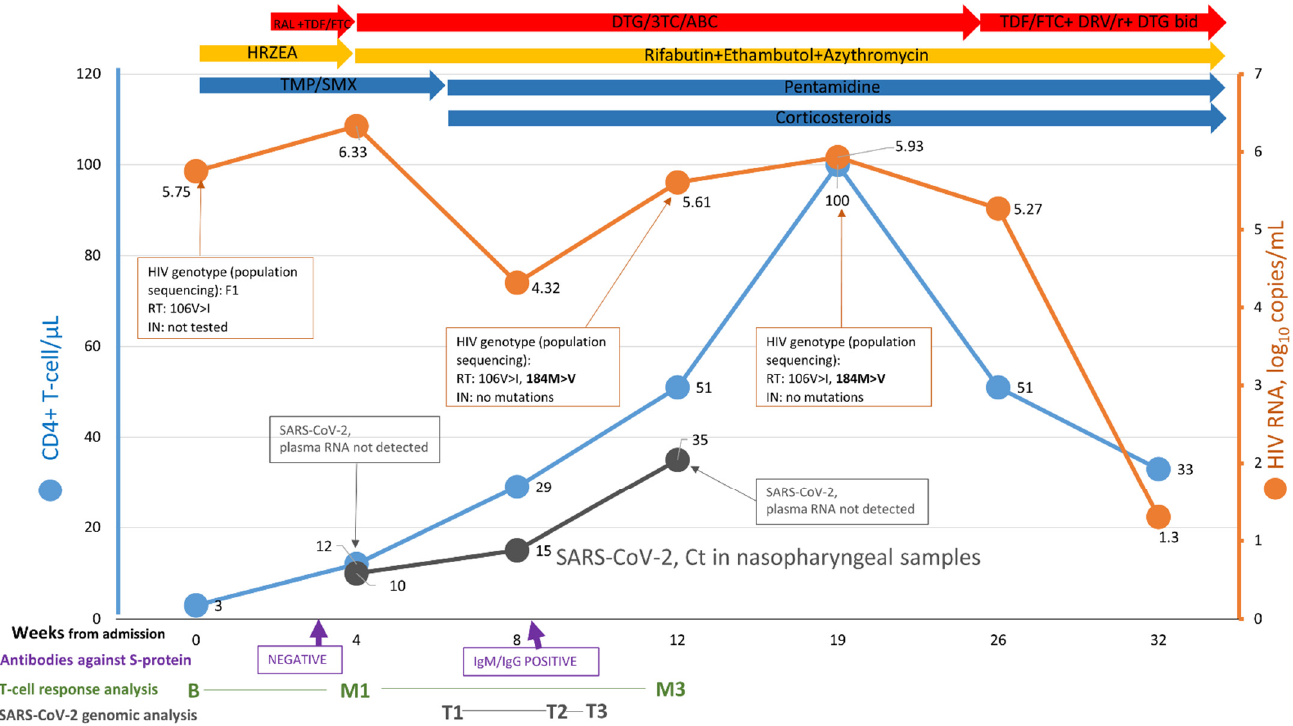
Figure 1. Timeline—RAL, raltegravir; TDF, tenofovir disoproxil fumarate; DTG, dolutegravir; ABC, abacavir; 3TC, lamivudine; FTC, emtricitabine; DRV/r, darunavir/ritonavir; bid, twice a day; TMP/SMX, trimethoprim/sulfamethoxazole; RT, reverse transcriptase; IN, integrase; HRZEA, isoniazid, rifampin, pyrazinamide, ethambutol, azithromycin; Ct, cycle threshold of severe acute respiratory syndrome coronavirus 2 (SARS-CoV-2) in nasopharyngeal samples. Time points of T-cell response analysis: B, Baseline; M1, Month 1; M3, Month 3. Time points of SARS-CoV-2 genomic analysis from nasopharyngeal samples: T1, time point 1; T2, time point 2; T3, time point 3. Time points represent estimations through the